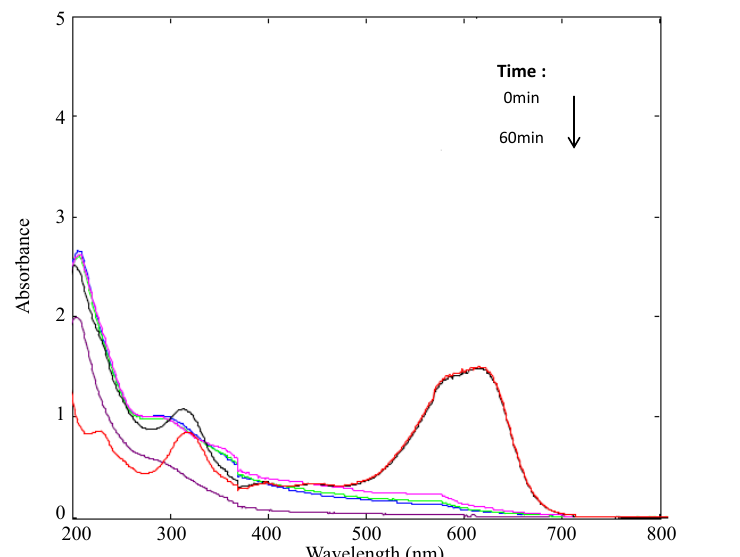
Figure 7 : UV-Vis spectra of NBB water solutions during the treatment process with Fe(III)P 2 W 12 MO 6 /H 2 O 2 system. (pH=3, [catalyst mass=0.005g, [H 2 O 2